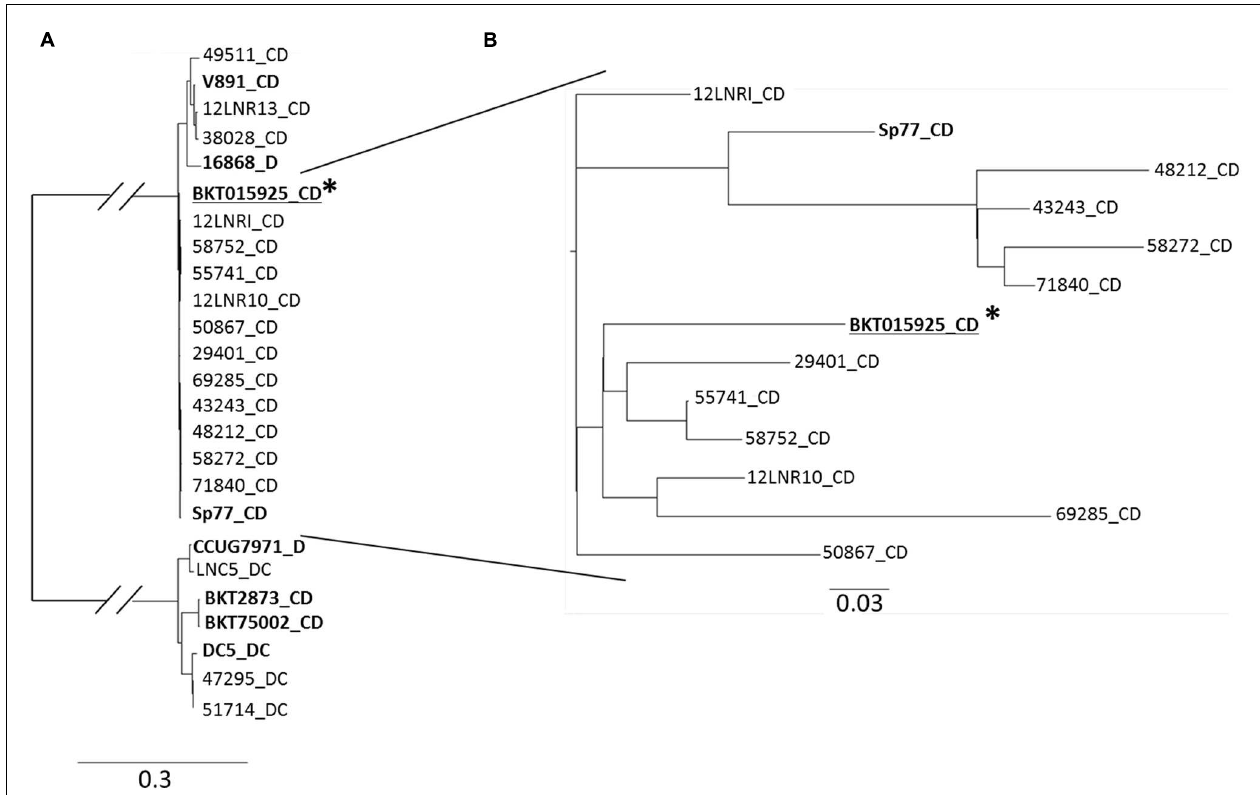
FIGURE 3 | C. botulinum group III SNP phylogeny profiling. (A) Maximum likelihood tree created from concatenated SNPs sequences using CSI phylogeny webserver 1.1 (https://cge.cbs.dtu.dk/services/CSIPhylogeny; Kaas et al., 2014). C. botulinum group III genome sequences from Skarin and Segerman (2014) are bolded. ∗ C. botulinum type C/D reference sequence used. (B) Highly genetically related French C. botulinum strains Group III type C/D isolates were analyzed separately to solve a better discriminatory